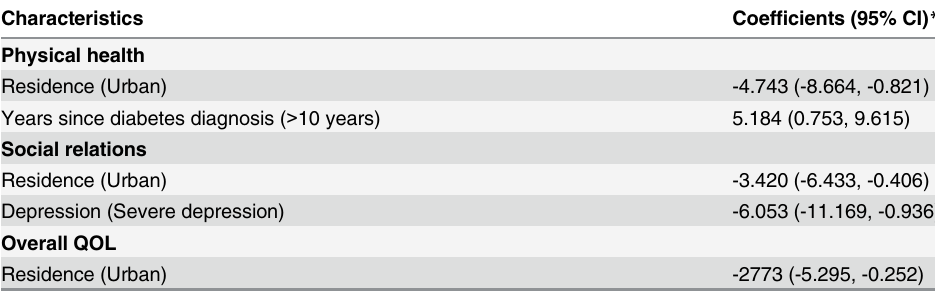
Table 6. Multivariate linear regression analysis between independent variables and QOL